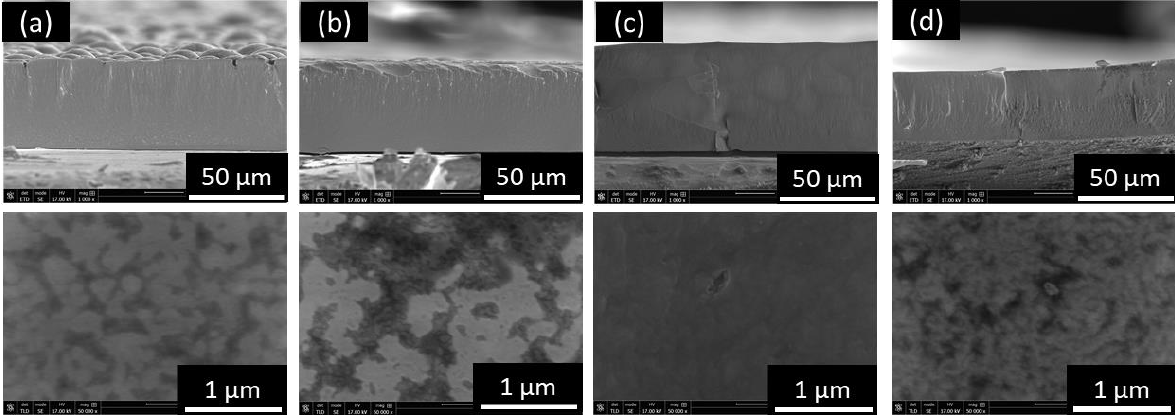
Figure 1. SEM images of PbTe electrodeposited at different applied potential: ( a ) − 0.9, ( b ) − 0.95, ( c ) − 1.0, and ( d ) − 1.05 V with 550 mM (TeO 32 − ), 100 mM (Pb 2+ ), and (EDTA 4 − )/(Pb 2+ ) of 7.5 at pH of 12.3 and temperature of 23 °C. The top row im- ages are cross-section view, and the bottom row images are top view. Pb content of the four samples are 47%. The XRD patterns of as-deposited PbTe films are shown in Figure 2. Further adjust- ment of the crystallinity of the films were achieved by thermal treatment in a reductive atmosphere (i.e., 95 vol.% N 2 + 5 vol.% H 2 ). The thermal treatment process was carried out in a reductive atmosphere to prevent the oxidation of PbTe during the treatment. The an- nealing process was carried out at 200 °C for 2 and 10 h. The deposition rate increase from 120 to about 160 µm h −1 when applied potential changed from −0 .9 to −1 .05 V. According to Equation (1) and Buttler –Volmer’s equation, both nucleation rate and grain growth rate is enhanced dramatically by applied potential. Namely, the grain size of PbTe turned out to be almost the same with dominant crystal orientation of (111) (Figure 2) and nano-crys- talline structure. For Tellurium, the preferred orientation is (111).